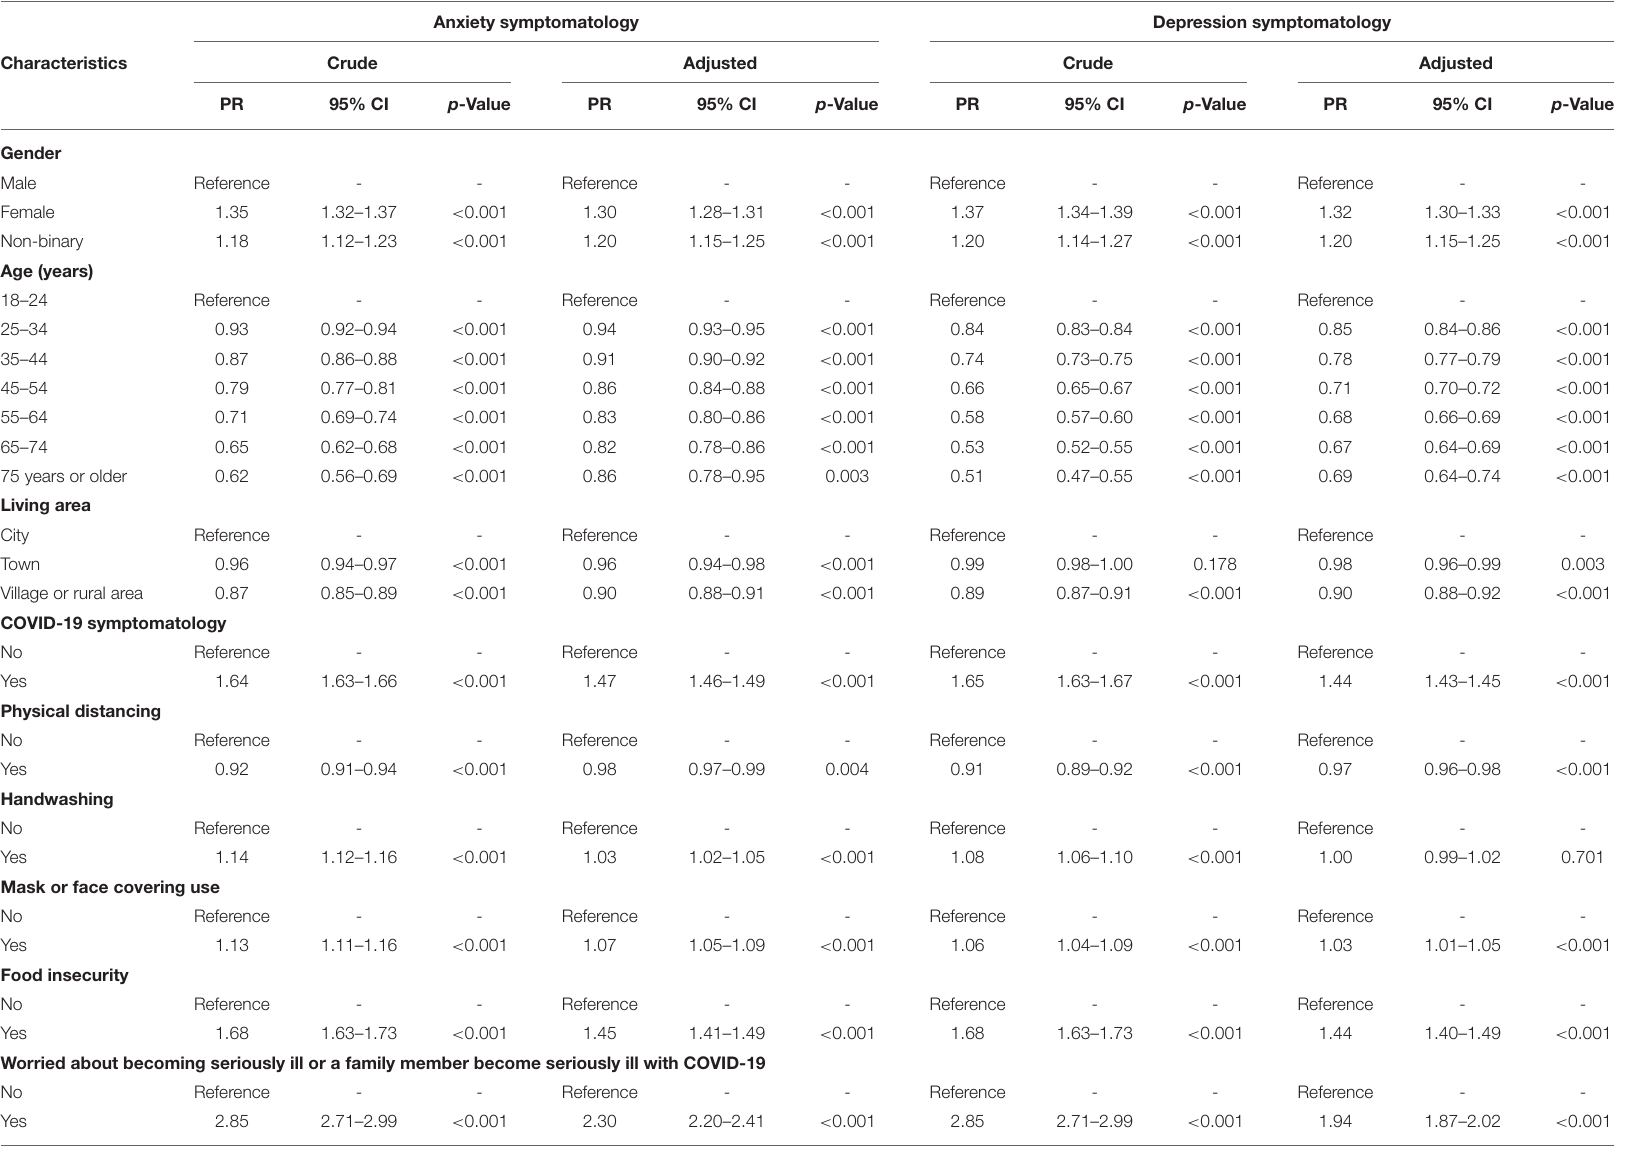
TABLE 3 | Crude and adjusted generalized linear models of Poisson family with logarithmic link to evaluate the factors associated with anxiety or depression in the study